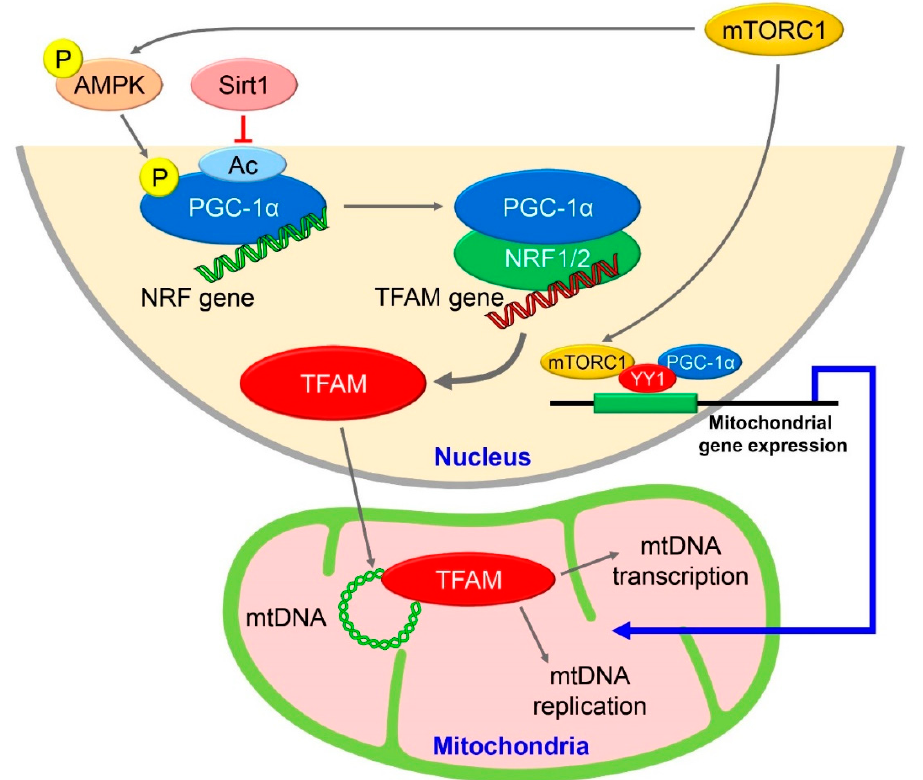
Figure 2. mTORC1 and mitochondrial biogenesis. AMPK, phosphorylated by mTORC1, promotes NRF gene transcription by activating PGC1 α , which, in turn, activates mtDNA replication and tran- scription via TFAM. At the same time, activated mTORC1 contributes to mitochondrial biogenesis by promoting mitochondrial gene expression by binding to PGC1 α and YY1 in the nucleus. Gray arrows indicate activation, line segmant in red indicates inactivation. Blue arrows indicate transcribed mitochondrial genes function within mitochondria [65].